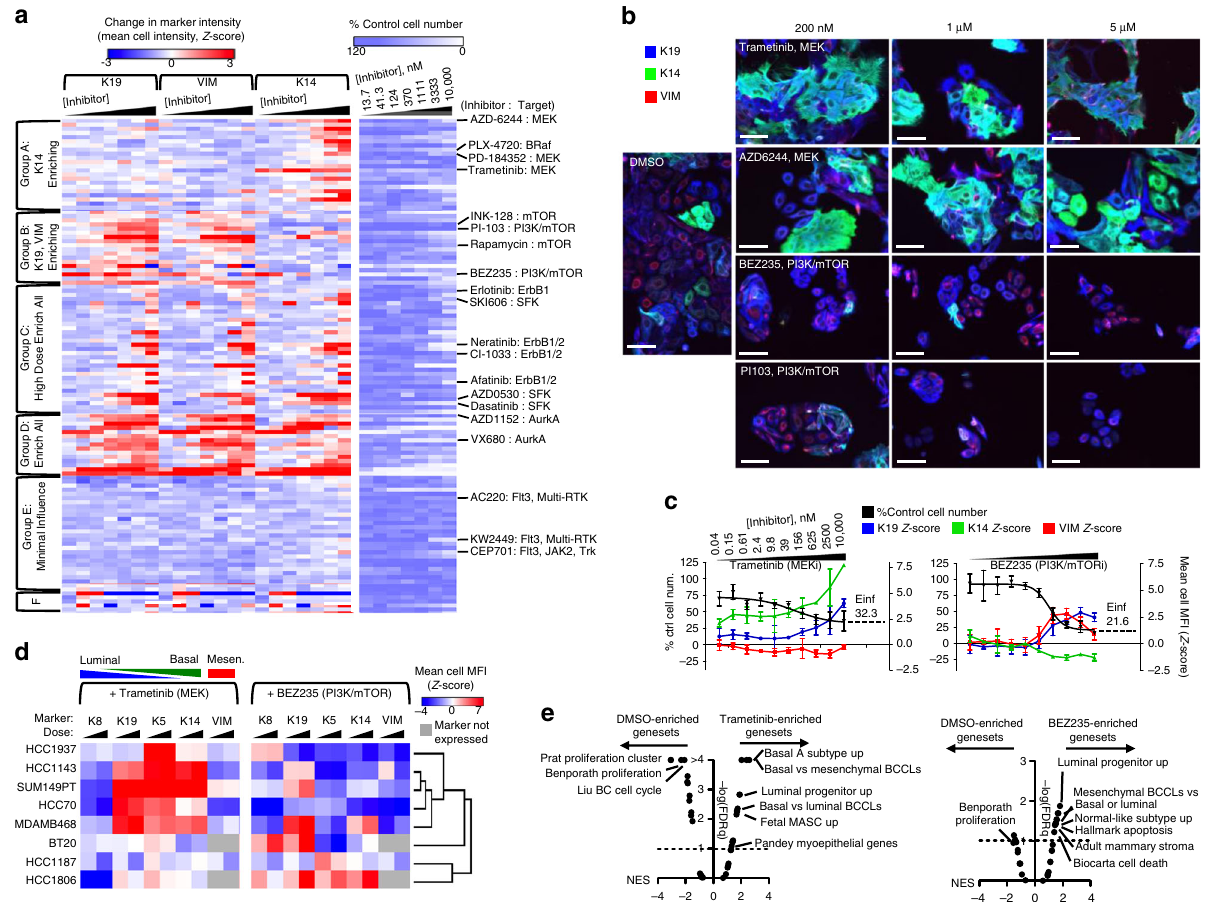
Fig. 2 Targeted therapies enrich distinct drug-persisting differentiation states. a Heatmaps show the change in K19, VIM, and K14 expression compared to DMSO control wells as a Z -score (left), and change in proliferation (right, percent of control) of HCC1143 cells following 72 h exposure to seven doses of 119 targeted therapeutics. K-means clustering on differentiation marker expression shows six distinct clusters. Select drugs from each cluster and their primary therapeutics target(s) are labeled to the right. A full list of drugs and responses is in Supplementary Dataset 2. b IF images of HCC1143 cells following 72 h treatment with increasing doses of MEK inhibitors Trametinib and AZD6244 and the PI3K/mTOR inhibitors BEZ235 and PI103, or a DMSO control, showing K19 (blue), K14 (green), and VIM (red), scale bars = 100 μ m. c Graphs of therapy-induced changes in cell number (black, left axis) and mean-cell MFI (right axis, as Z -score) of K19 (blue), VIM (red), and K14 (green), in HCC1143 cells following 72 h incubation with increasing doses of Trametinib or BEZ235. The projected maximum level of inhibition, or Einf, is shown for each drug. d Heatmaps of the change in mean-cell MFI ( Z -Score) for K8, K19, K5, K14, and VIM is shown for eight basal-like BCCLs following 72 h incubation with 250 or 2500 nM Trametinib (left) or BEZ235 (right). Unsupervised clustering, using data from both agents, was used to group cell lines based on phenotypic response. Markers for luminal, basal, and mesenchymal phenotype are indicated. e GSEA results as a volcano plot of Normalized Enrichment Score (NES, x -axis) vs. FDRq ( − log, y -axis) examining 32 genesets related to mammary cell states and breast cancer subtypes, enrichment compared between DMSO and 1 μ M Trametinib (left), or DMSO and 1 μ M BEZ235 (right) in HCC1143 cells treated for 6 days. Select top-enriched genesets are